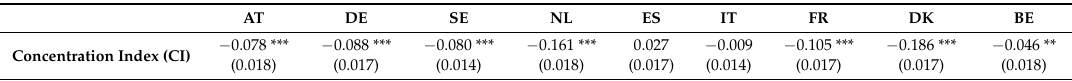
Table 2. Inequality in use of home care services, standard errors in